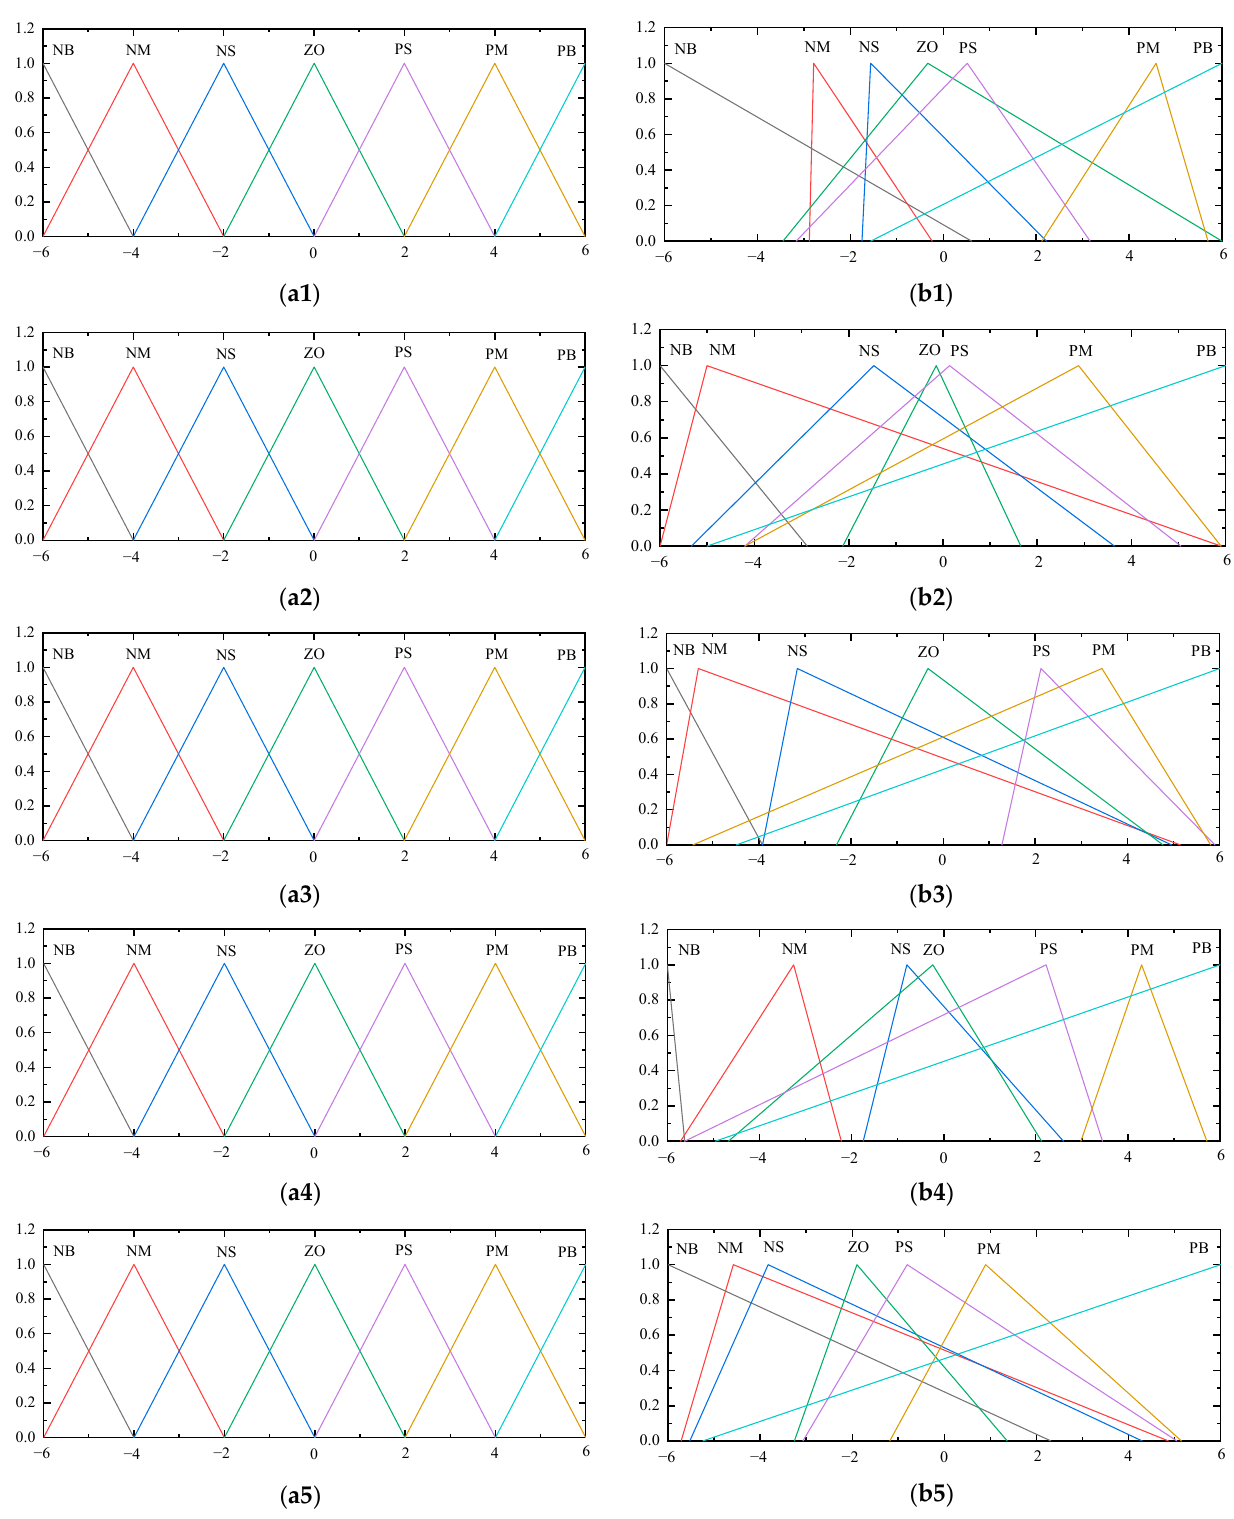
Figure 12. ( a1 – a5 ) is the membership function of deviation e, deviation differential ec, proportional Kp, integral Ki, and differential Kd, before optimization. ( b1 – b5 ) is the membership function of the optimized deviation e, deviation differential ec, proportional Kp, integral Ki, and differential Kd, after optimization.